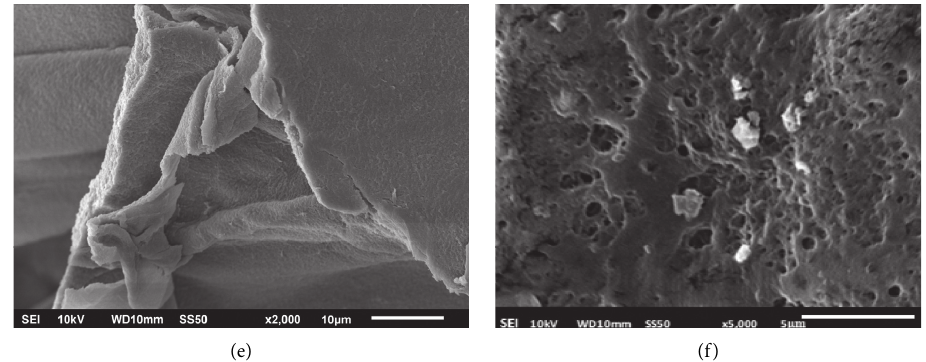
Figure 2: (a) Chi-EGDE-Fe; (b) size of the bead; (c, d) SEM image of the external surface; (e, f) SEM image of the internal surface.